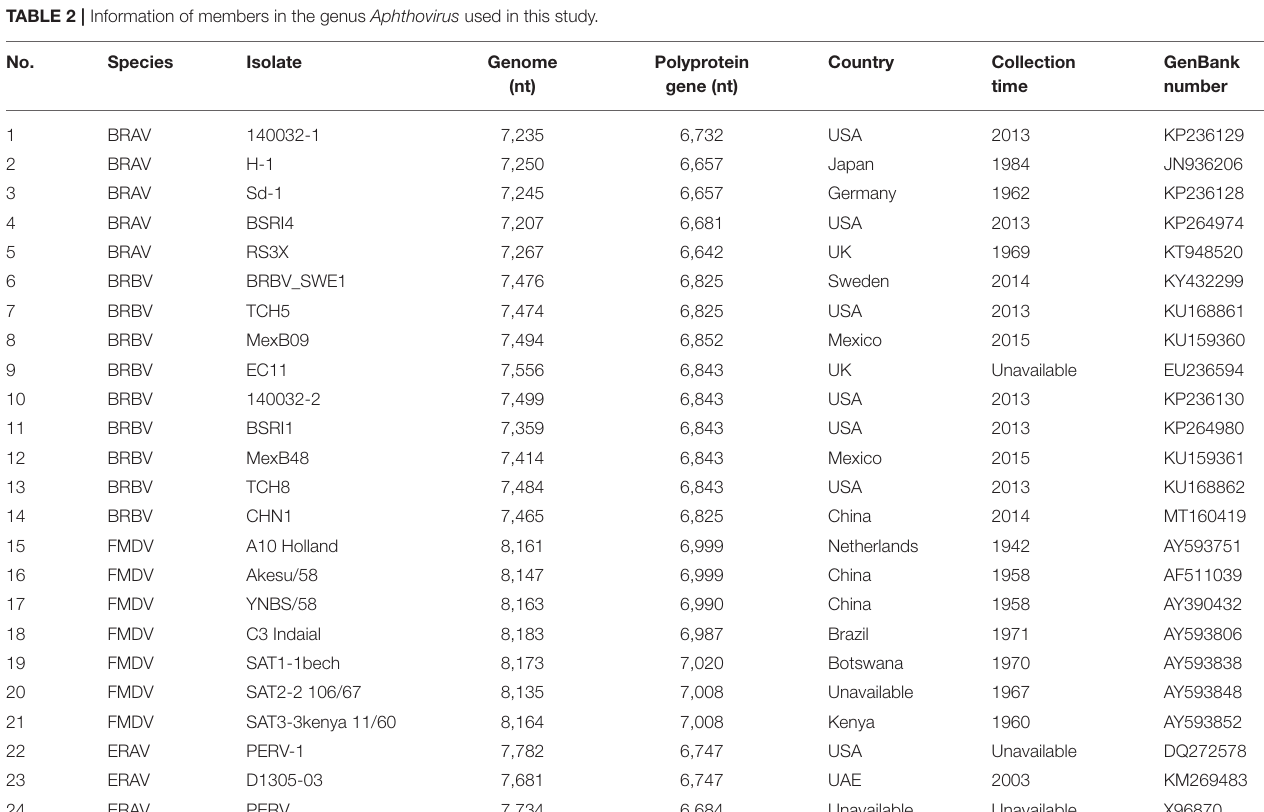
TABLE 2 | Information of members in the genus Aphthovirus used in this study.